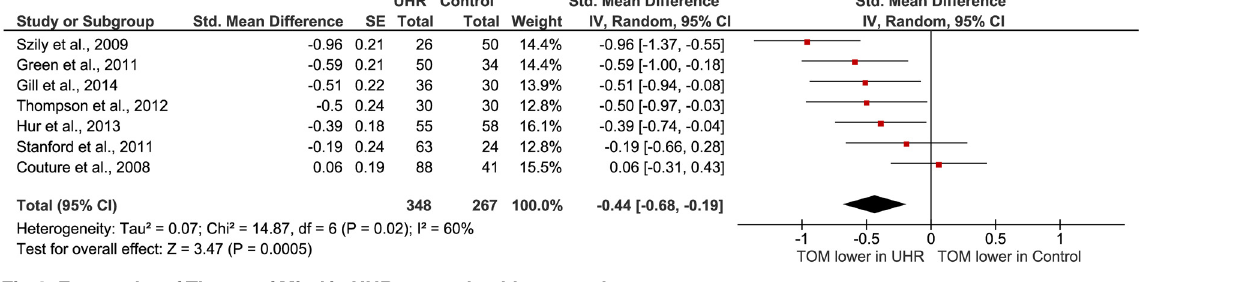
Fig 4. Forest plot of Theory of Mind in UHR versus healthy